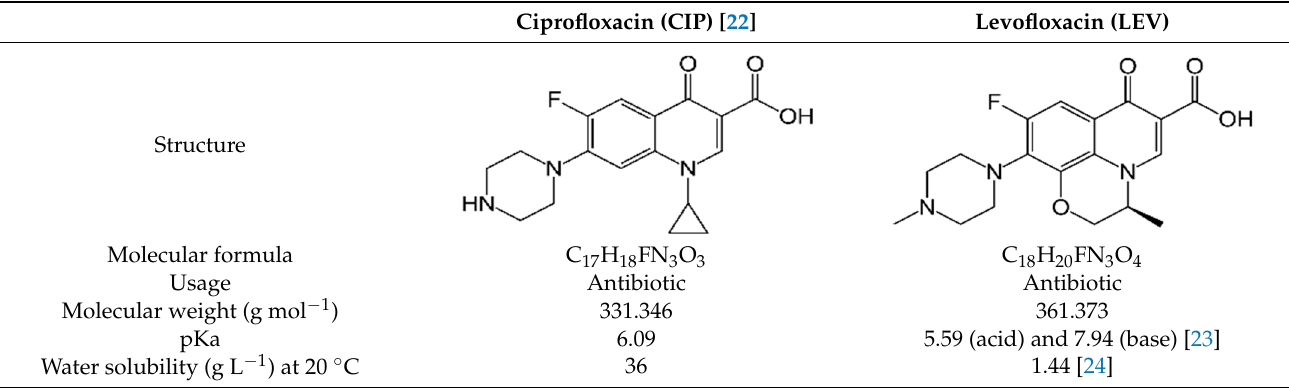
Table 1. Physicochemical properties of ciprofloxacin and levofloxacin.